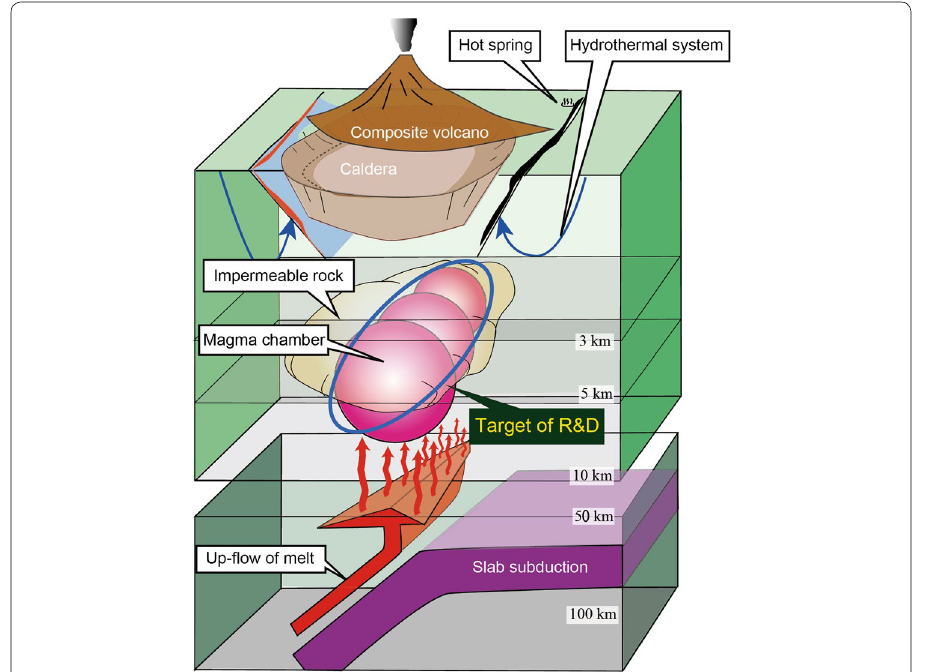
Fig. 2 Conceptual model of the JBBP project for supercritical geothermal systems in northern Honshu, Japan (Asanuma et al. 2015). These systems lie above shallow magma chambers that are associated with Miocene and younger caldera complexes in the Tohoku